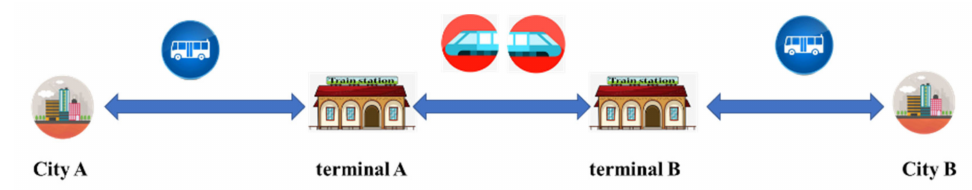
Figure 2. Schematic diagram of urban agglomeration trip chain.